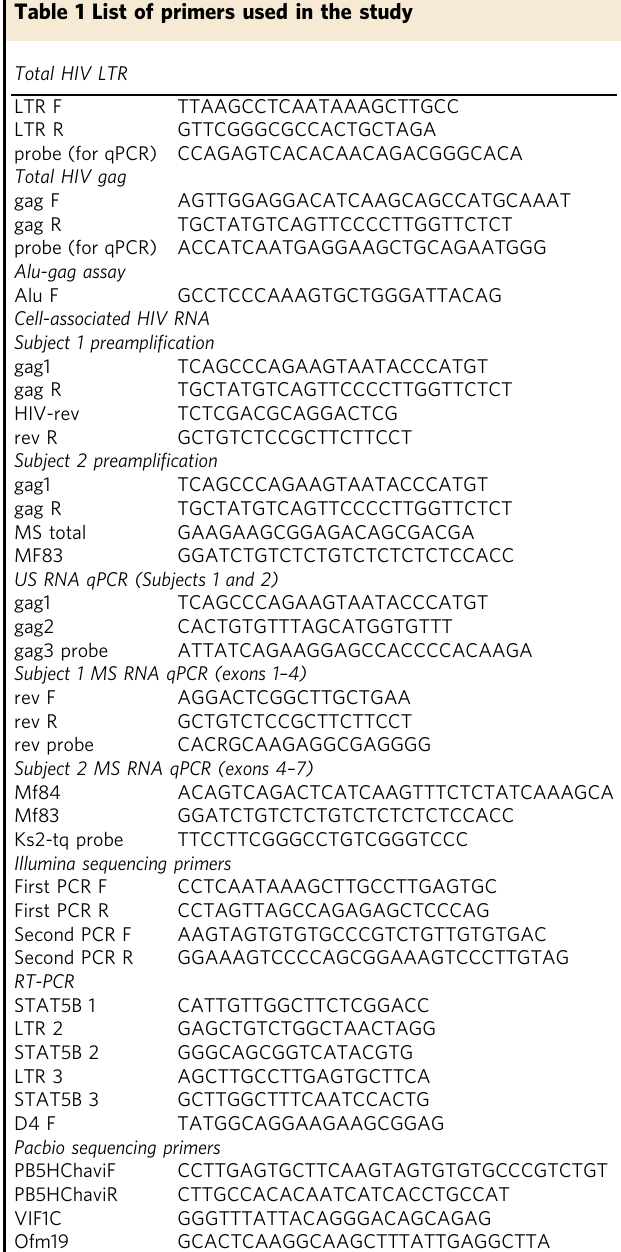
DNA isolation and quanti fi cation of HIV DNA . DNA was isolated from PBMCs using the Gentra Puregene Cell Kit (Qiagen). HIV DNA was quanti fi ed by total HIV against the LTR (primers LTR F and LTR R; Table 1) or gag regions (primers gag F and gag R; Table 1). Integrated HIV DNA was measured using primers Alu F and gag R; Table 1). First-step PCR reactions were cycled using the Nexus Master Cycler (Eppendorf) and qPCR reactions were cycled on a 7500 FAST real-time instrument (ThermoFisher). For total HIV, PCR conditions for the fi rst round were: 95°C for 2min; then 95 °C for 15s, 64 °C for 45s, 72 °C for 1min for 12 cycles; and then 72°C for 10 min. For Alu-gag measurements the following PCR conditions for the fi rst round were used: 95°C for 2min; then 95 °C for 15 s, 56 °C for 45s, 72 °C for 3:30min for 40 cycles; and then 72°C for 10 min. Fifteen microliters of the fi rst-round PCR reactions were run on the qPCR instrument